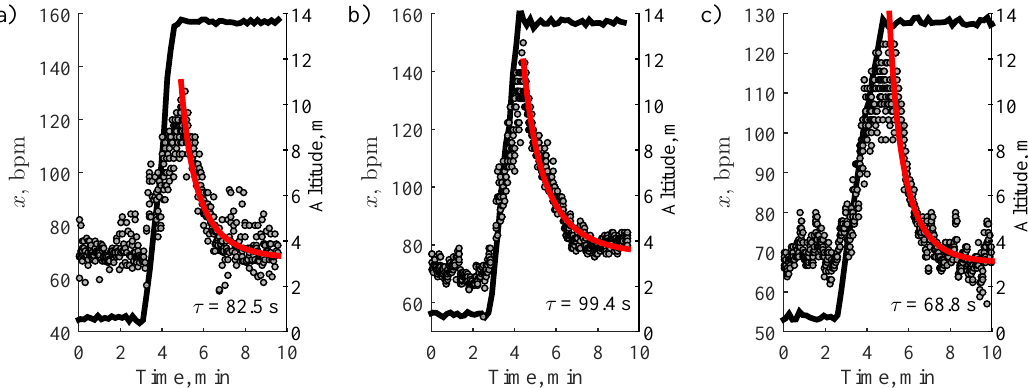
Figure 8. Stair climbing activities from the elderly individuals, instructed to safely ascend the stairs at their comfortable speed: ( a ) 74-year-old female, average stair climbing rate—61 steps/min, ( b) 72-year-old female, average stair climbing rate—65 steps/min, ( c ) 74-year-old female, average stair climbing rate—42 steps/min. The black line stands for